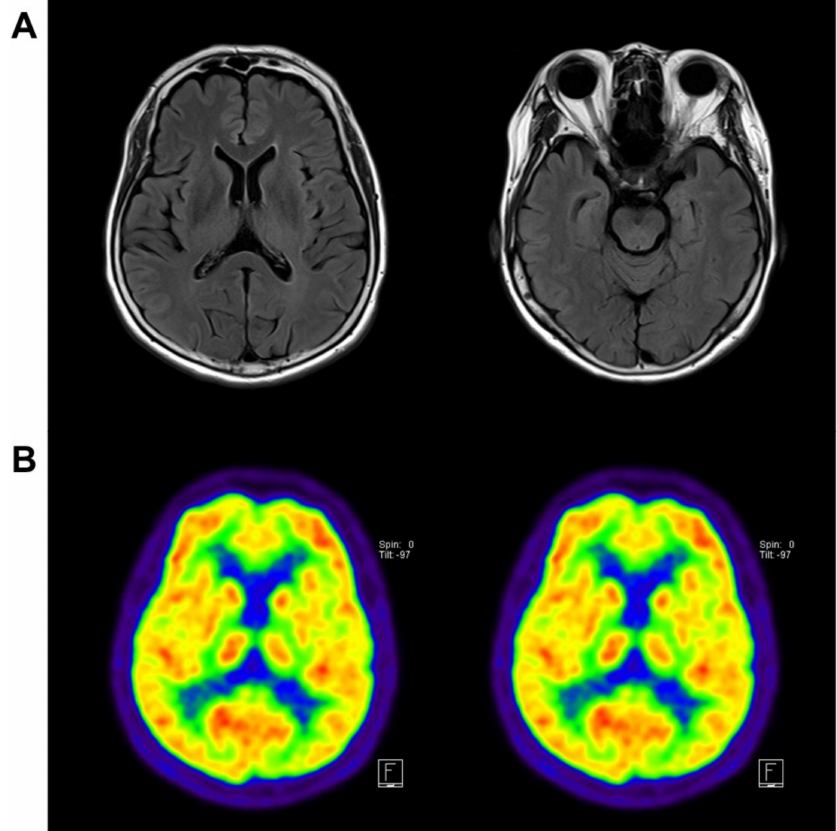
Figure 5. Imaging data of the patient with a PS2 Gly56Ser mutation. ( A ) MRI findings revealing mild parietal and hippocampal atrophy and ( B ) FDG-PET findings showing temporoparietal hy- pometabolism. Abbreviations: MRI, magnetic resonance imaging; FDG-PET, 18F-fluorodeoxyglucose positron emission